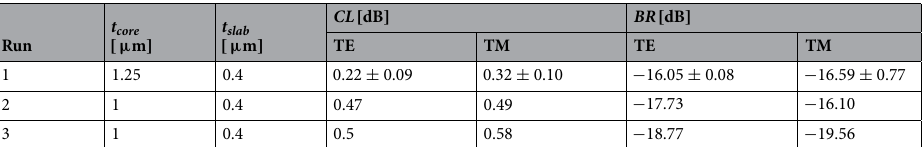
Table 5. Coupling loss and back-reflection values for three fabrication runs involving 1.25 µ m and 1 µ m -thick SiN and SOI waveguides. Both TE and TM cases are presented. The back-reflection values are related in each case only to the fundamental mode.